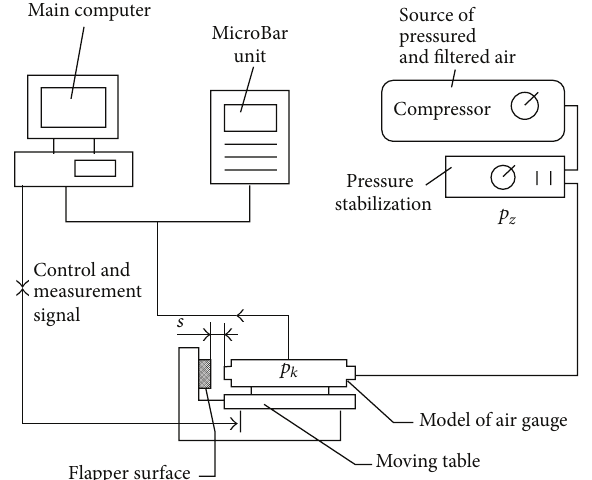
Figure 2: Scheme of the static characteristics investigation set